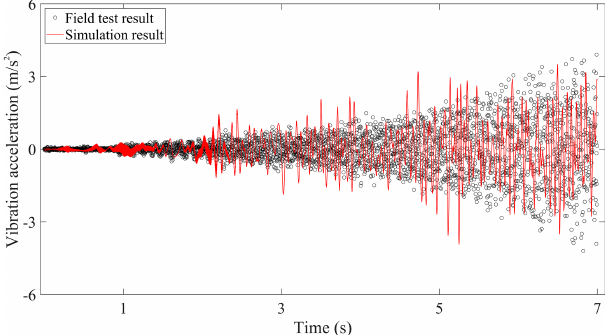
Figure 5. Comparison of vertical vibration responses of the car body.